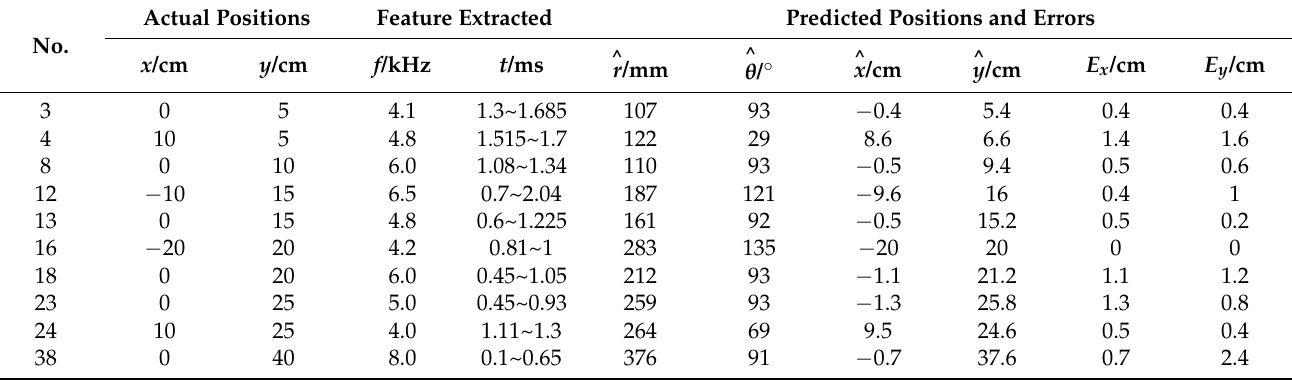
Table 1. Feature extracted and impact localization results on the curved composite